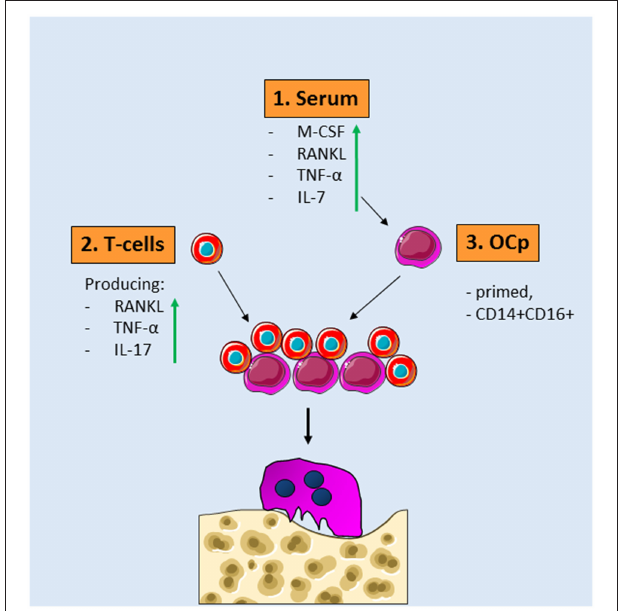
FIGURE 2 | Common denominators for osteoclast formation in diseases with inflammatory bone loss. 1 . Serum of patients with inflammatory bone loss diseases contains more osteoclastogenesis stimulating factors such as RANKL, TNF- α , IL-7, and M-CSF. 2 . These serum factors prime OCp present in peripheral blood. These OCp are skewed toward more CD14 + CD16 + cells. 3 . T-cells from patients with inflammatory bone diseases express more IL-17, RANKL, and TNF- α . When these different OCp and T-cells—both of them different from controls—are added together, more osteoclasts are formed that are more active in bone